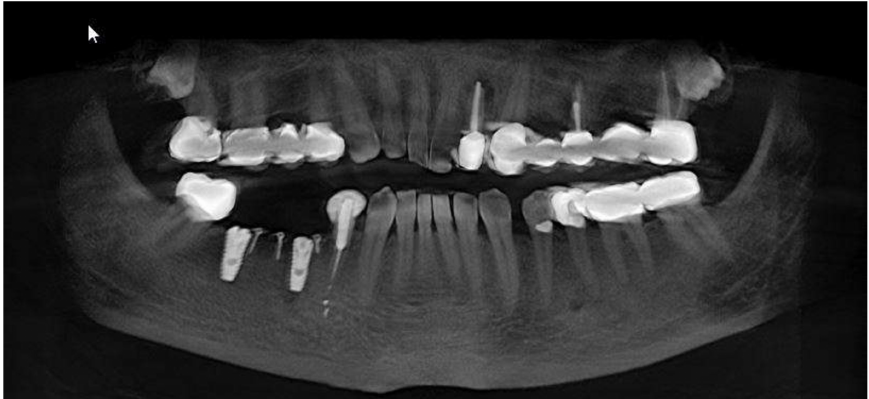
Figure 6. OPG aspect at follow-up of 7-months.